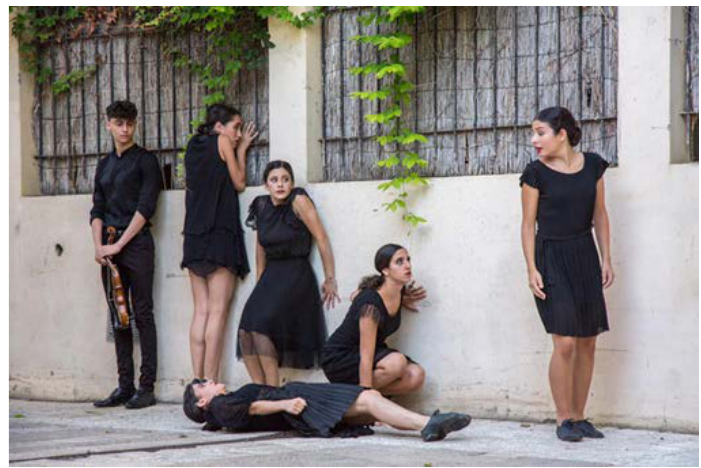
Figure 1. Echo : Hide and seek. Dancers: Shahed Jabarin, Layal Mazzawi, Rand Taha, Rima Naser Eeddin, Maria, Alkeesh. Violinist: Ibrahim Boulos (Photograph: Issa Freij).